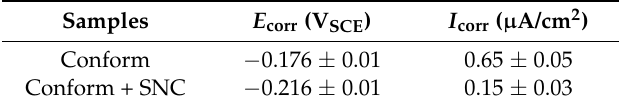
Table 1. Electrochemical parameters of conform and conform + SNC samples immersed in 0.1 M NaCl solution.